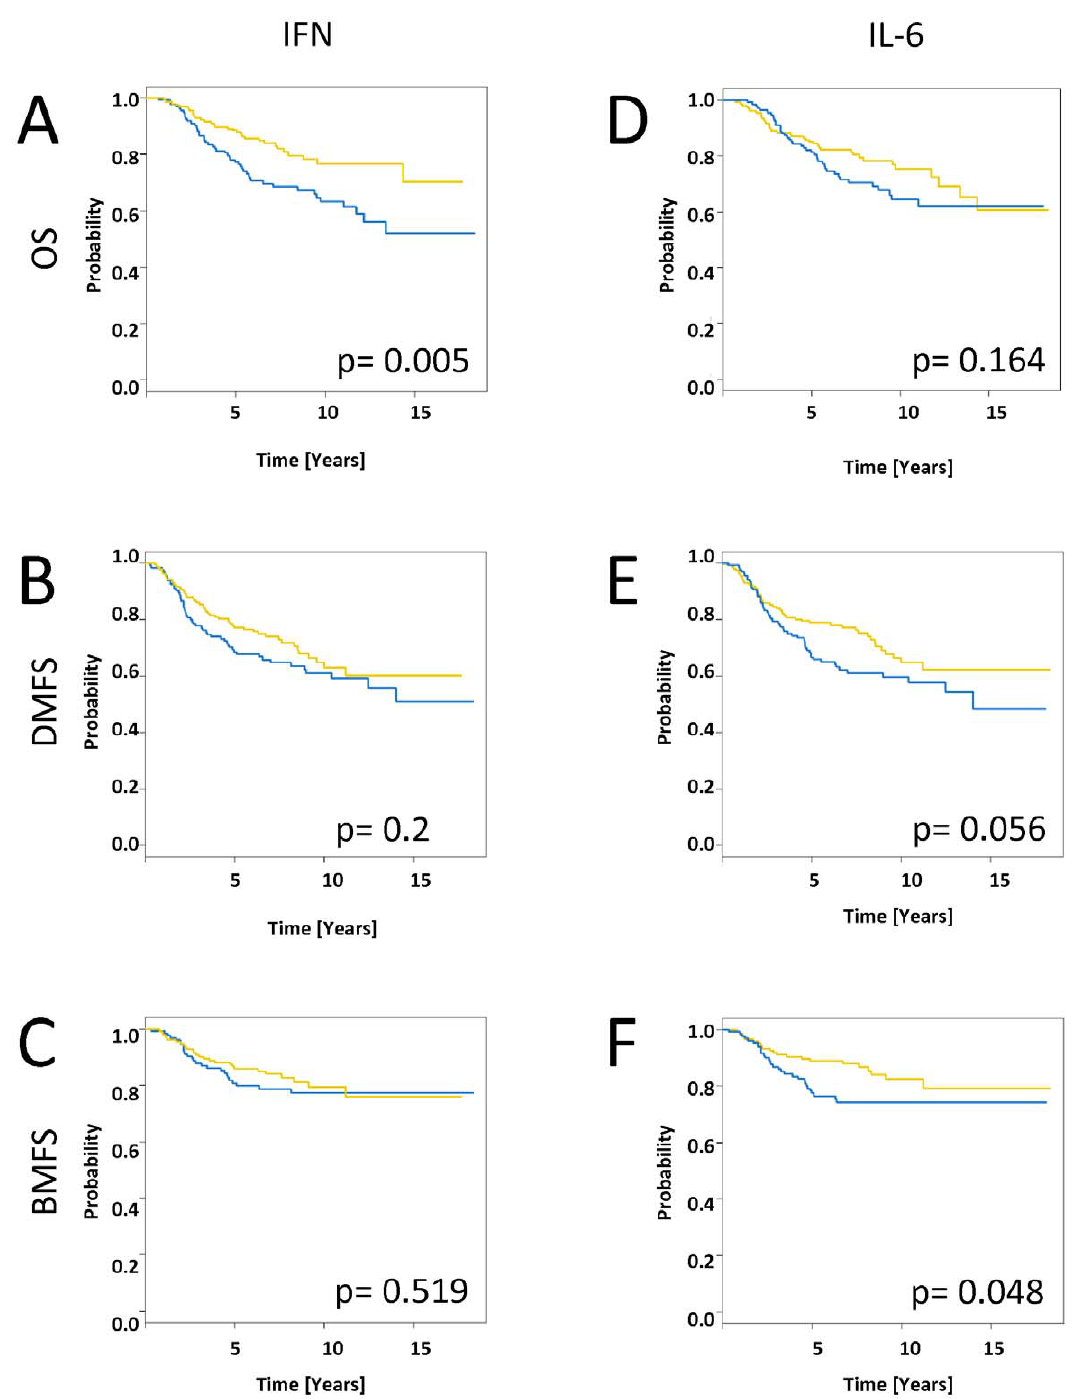
Figure 5. Effects of the ‘‘interferon response genes regulated by STAT1 signature’’ and ‘‘IL-6 gene signature’’ on bone metastasis formation. Kaplan-Meier plots for overall survival (OS) (A,D), distant metastasis-free survival (DMFS) (B,E) and bone metastasis-free survival (BMFS) (C, F) estimates are shown for the ‘‘interferon response genes regulated by STAT1 signature’’ and the ‘‘IL-6 gene signature’’. P-values are given for the Cox regression analysis. The ‘‘IL-6 gene signature’’ segregated tumors with a significant difference in BMFS. The colors of the curves correspond to the colors of the bars below the heatmaps of figure 4 A and B.